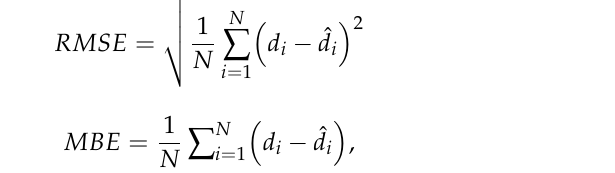
( b ) Figure 9. Example: ( a ) density histogram; and ( b ) CDF with distance. The determined parameters of the distributions describe the data collected at 50 cm intervals (and for distances above 10 m at 100 cm intervals). Figure 10 shows the parame- ters of normal distributions fitted with the collected data at reference distances. To simu- late the operation of the system at other distances, changes in distribution parameters can be modelled (approximated).